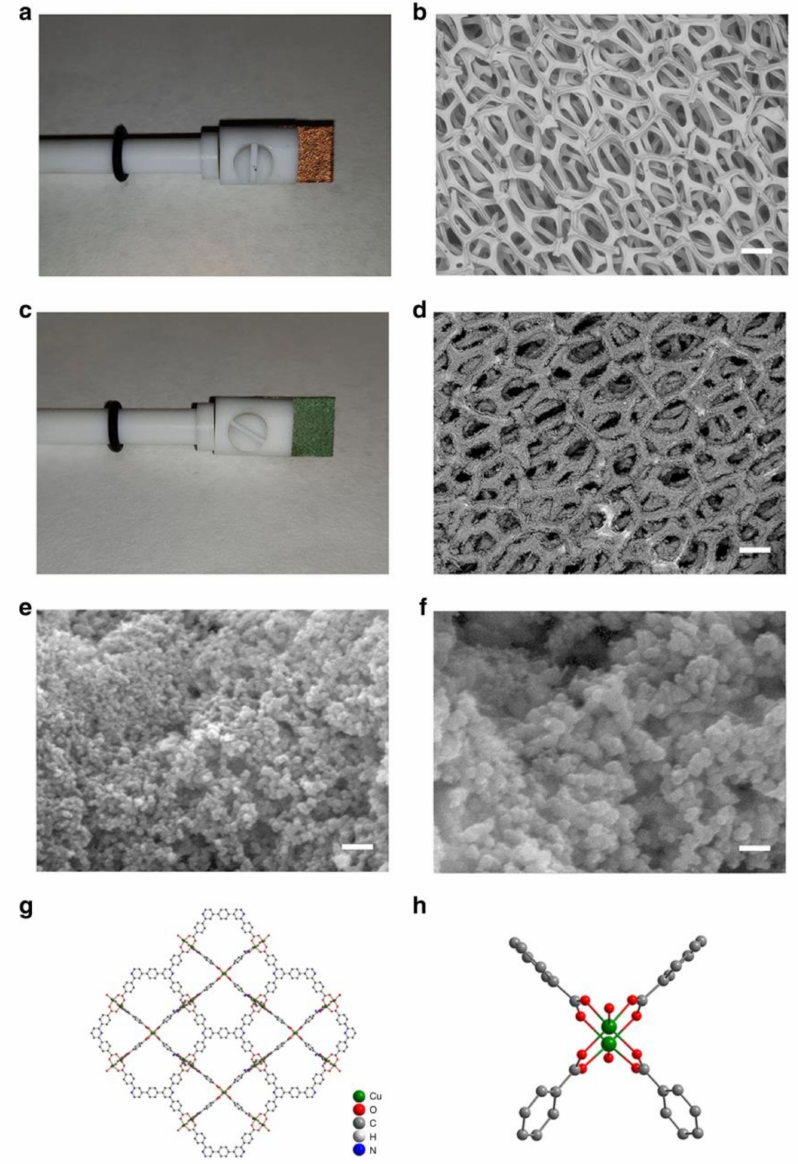
Figure 3. Photograph ( a ) and SEM image ( b ) of a fresh Cu-foam electrode (0.5 × 1.0 cm 2 ). ( c ) Photo- graph of the as-prepared electrode Cu 2 (L)-e/Cu (0.5 × 1.0 cm 2 ). ( d – f ) SEM images of the as-prepared electrode Cu 2 (L)-e/Cu. ( g , h ) Views of the crystal structure of [Cu 2 (L)]. Hydrogen atoms are omitted for clarity. The scale bars of ( b , d – f) are 300 µ m, 300 µ m, 300 nm and 100 nm, respectively. Reprinted with permission from Ref. [74]. Copyright 2020, Springer